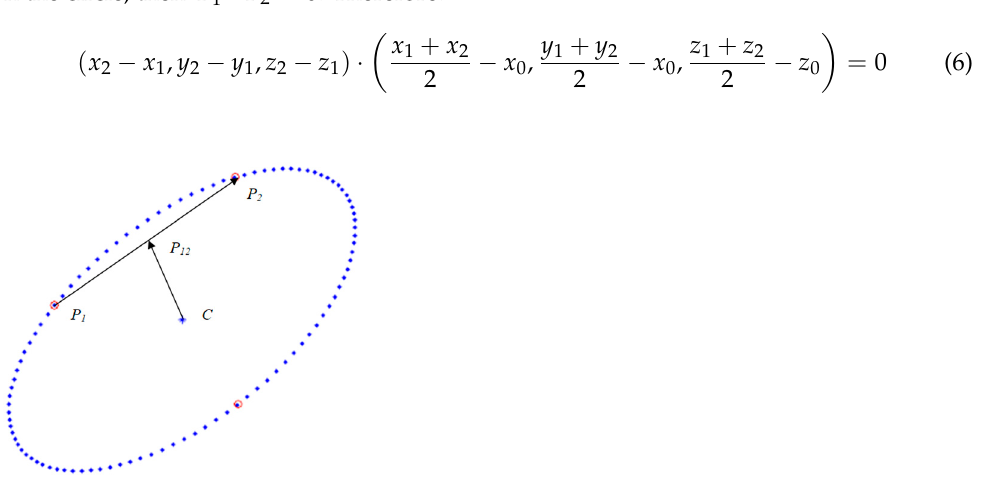
Figure 7. Schematic diagram of the principle of least squares.